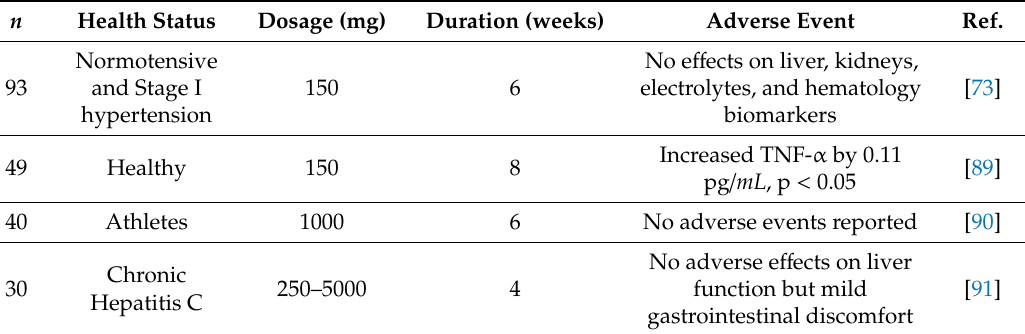
Table 7. Summary of studies on the safety of quercetin